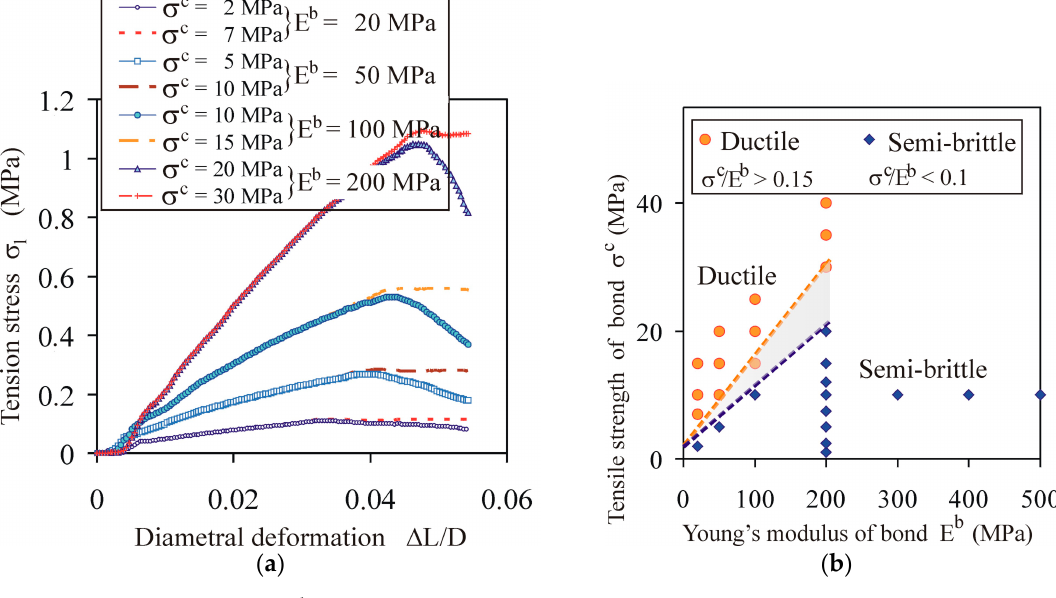
Figure 7. Effect of the σ c / E b ratio on the breakage behaviour of the agglomerates for σ z = 153 MPa: ( a ) comparison of the tension stress vs. diametral deformation σ 1 ( ∆ L / D ) for ductile and semi-brittle breakage of the agglomerates; ( b ) ( E b , σ c ) map of the ductile and semi-brittle behaviour of the agglomerates.